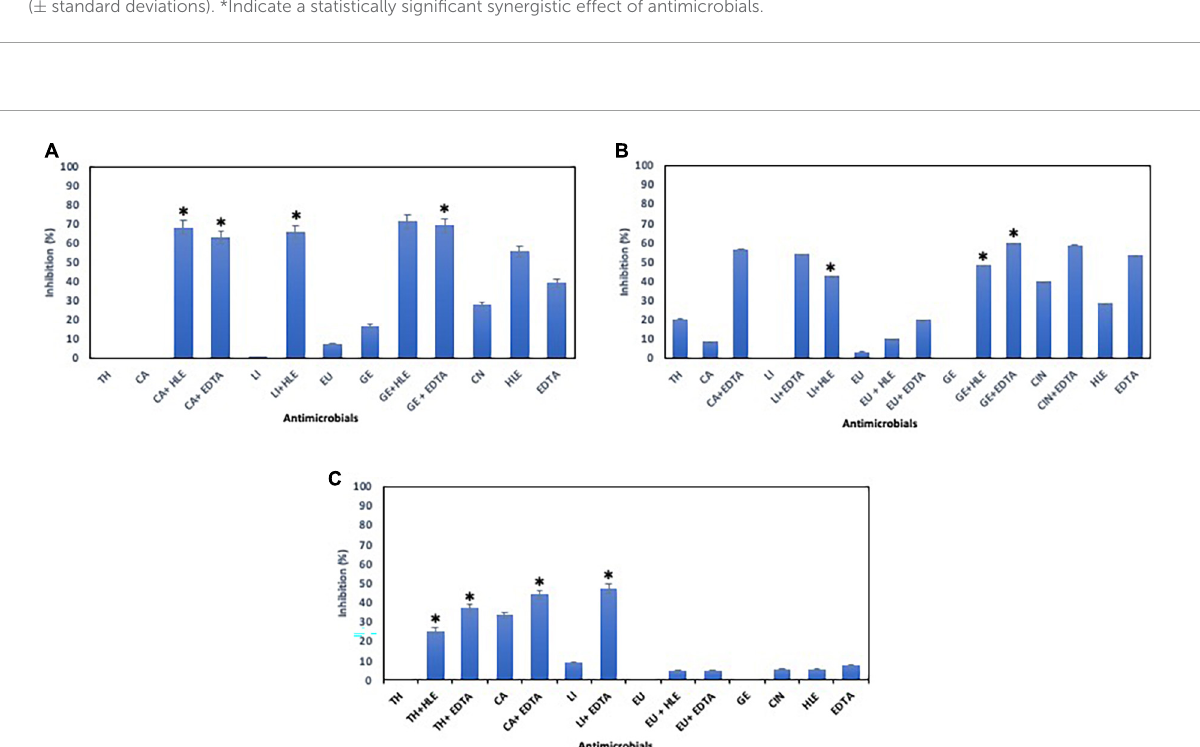
FIGURE3 Inhibition of biofilm formation of Staphylococcus sp. strains M7G10 (A) , M9G8 (B) and M31G11 (C) in the presence of EOCs (TH, CA, LI, EU, GE and CIN), EDTA, HLE or their synergistic combinations at MIC and sub-MIC (0.5 or 0.25) concentrations. Data were expressed as mean value ( ± standard deviations). *Indicate a statistically significant synergistic effect of